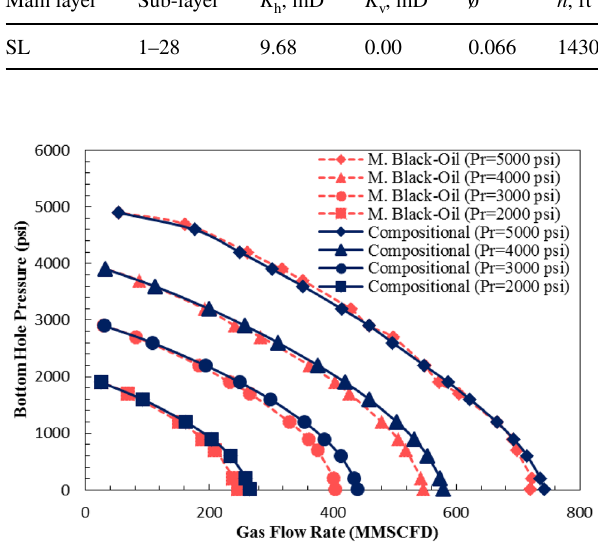
Fig. 4 Comparison of modified black-oil and compositional simula- tors for single-layer reservoir model